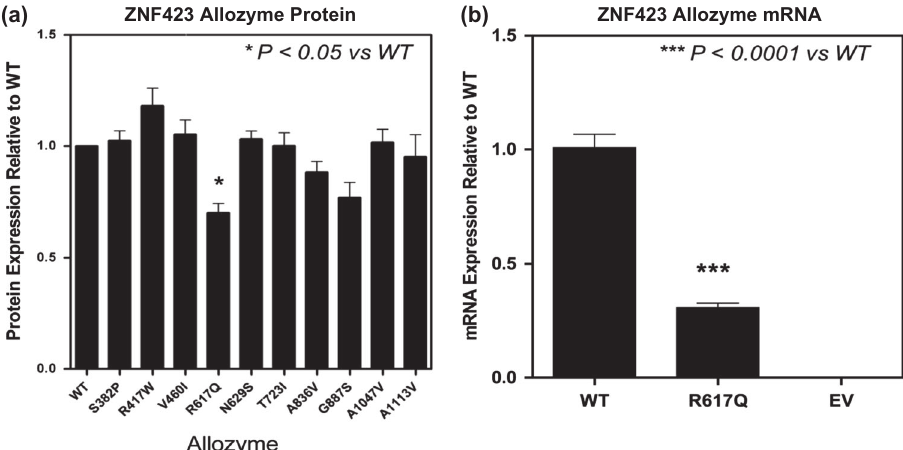
Fig. 5 a Levels of protein expression in COS-1 cells for ZNF423 WT and variant allozymes. b Levels of mRNA expression in COS-1 cells for the Q617 ZNF423 variant allozyme compared with that for the WT allozyme. Data represented as mean ± SEM for 6 determinations. EV = empty vector